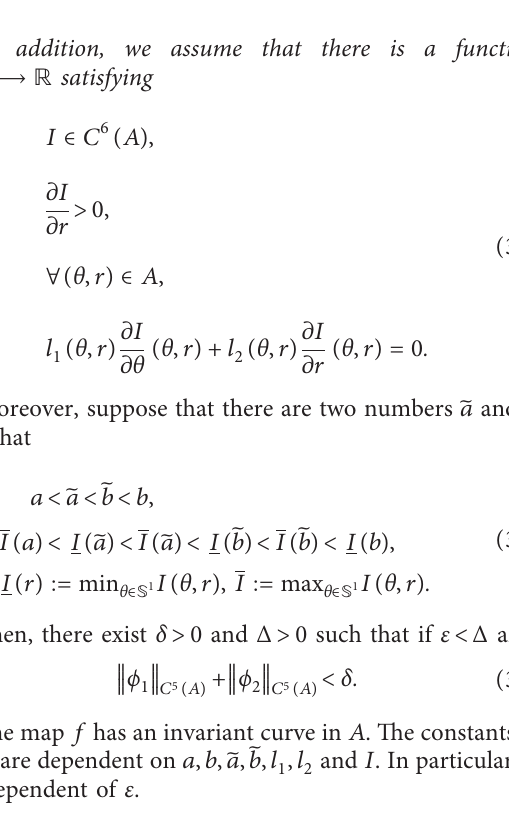
Figure 3: A periodic orbit of system (3) near the origin for a � 10 − 4 and its xyz -coordinates in function of time t